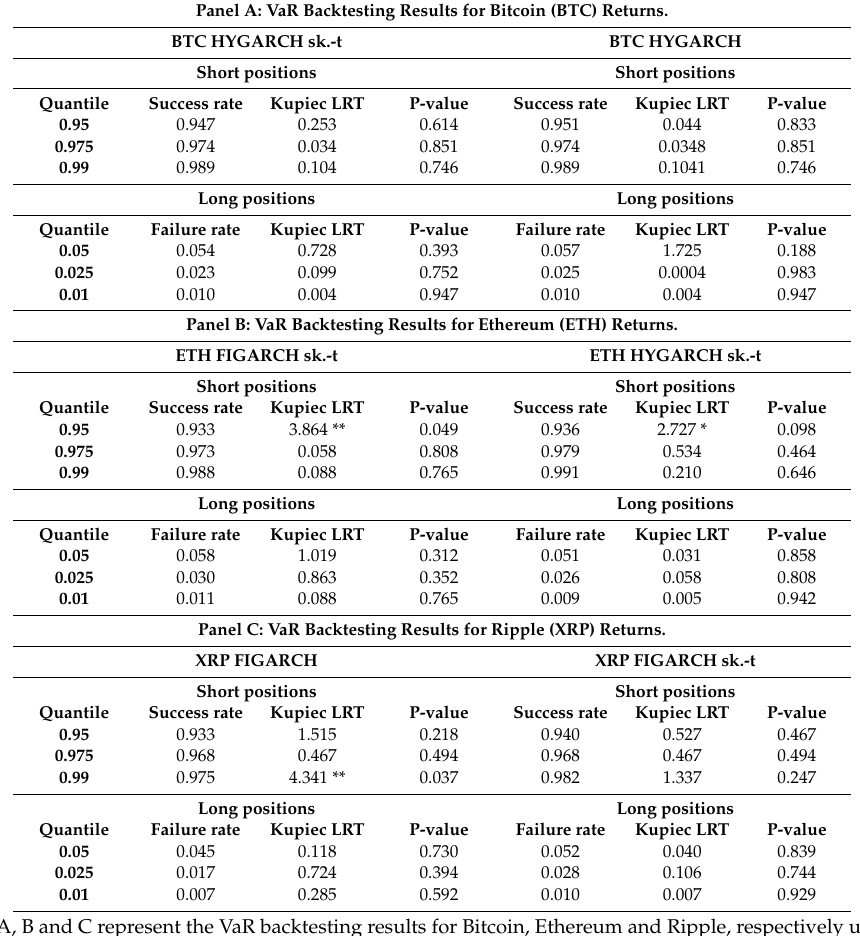
Table 6. In-sample Value-at-Risk (VaR) Backtesting for Cryptocurrency Returns. Panel A: VaR Backtesting Results for Bitcoin (BTC) Returns. BTC HYGARCH sk.-t BTC HYGARCH